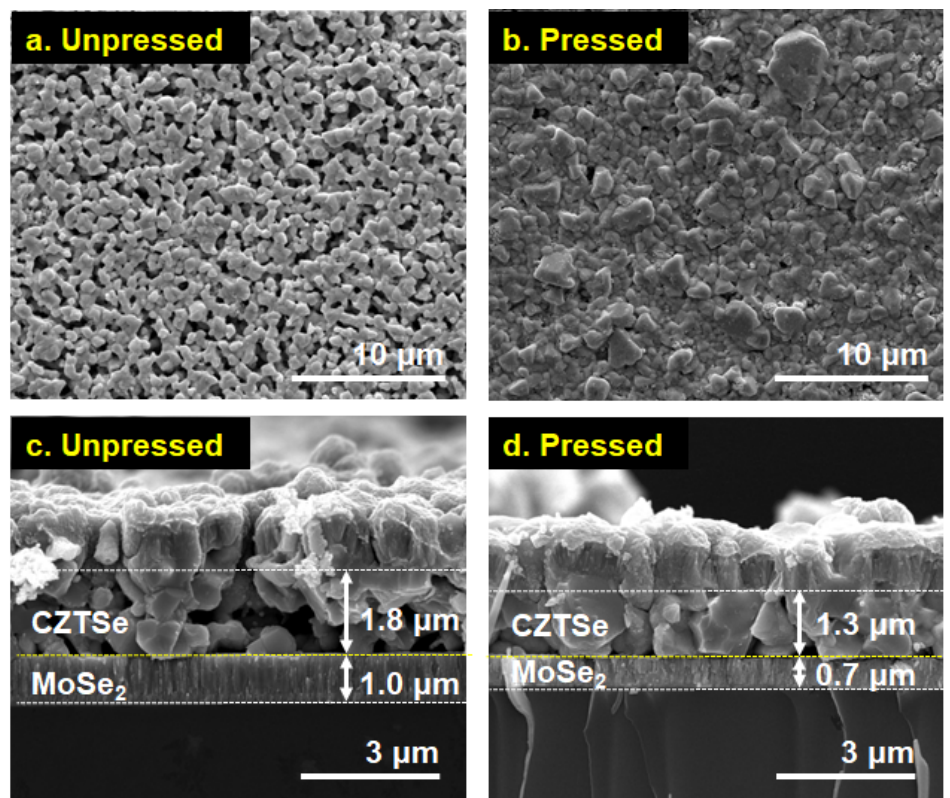
Figure 4. Top view and cross ‐ sectional SEM images of CZTSe solar cells with ( a , c ) unpressed and ( b , d ) pressed absorber layer with a device structure of SLG/Mo/CZTSe/CdS/i ‐ ZnO/ZnO:Al/Ni/Al. (Arrow bars indicate the thickness of each CZTSe absorber layer and MoSe 2 layer.)